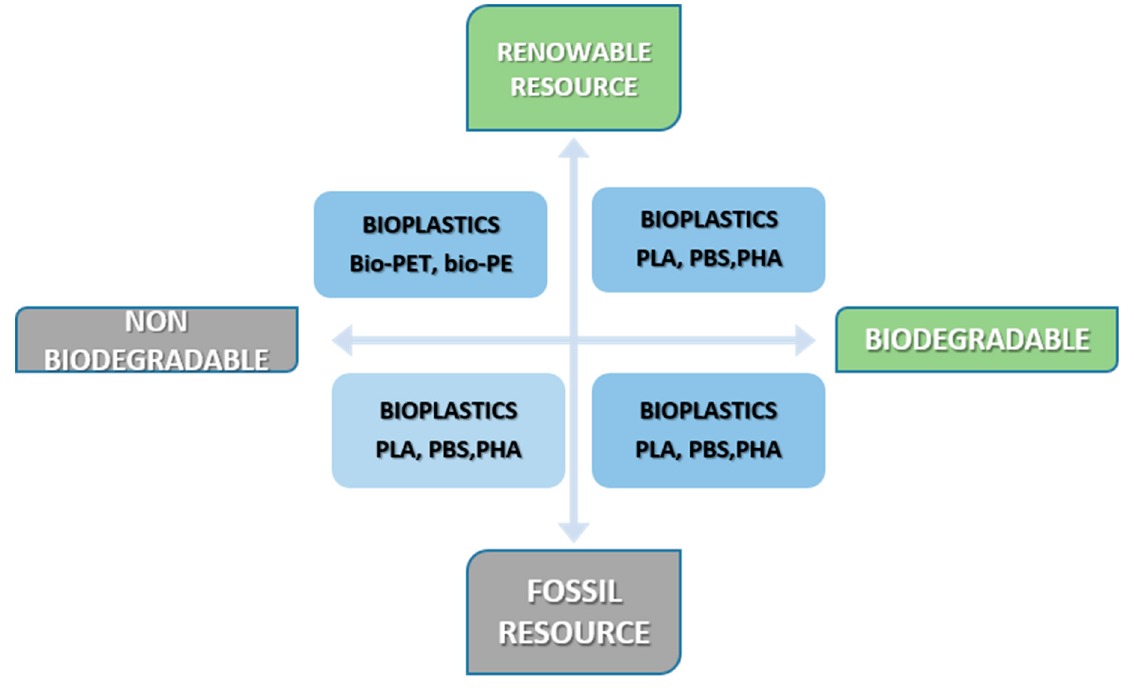
Figure 1. Types of bioplastics [13].